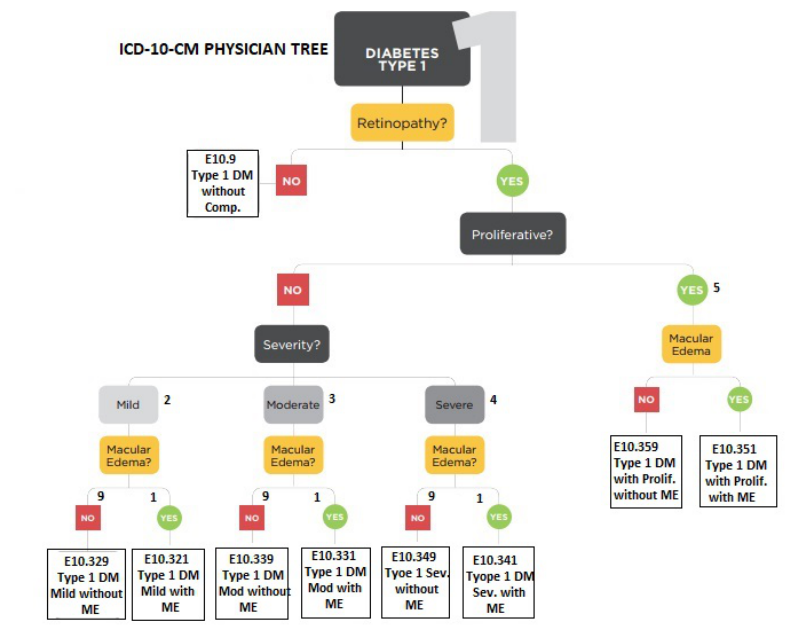
Figure 2. ICD-10 physician decision tree for diabetic retinopathy